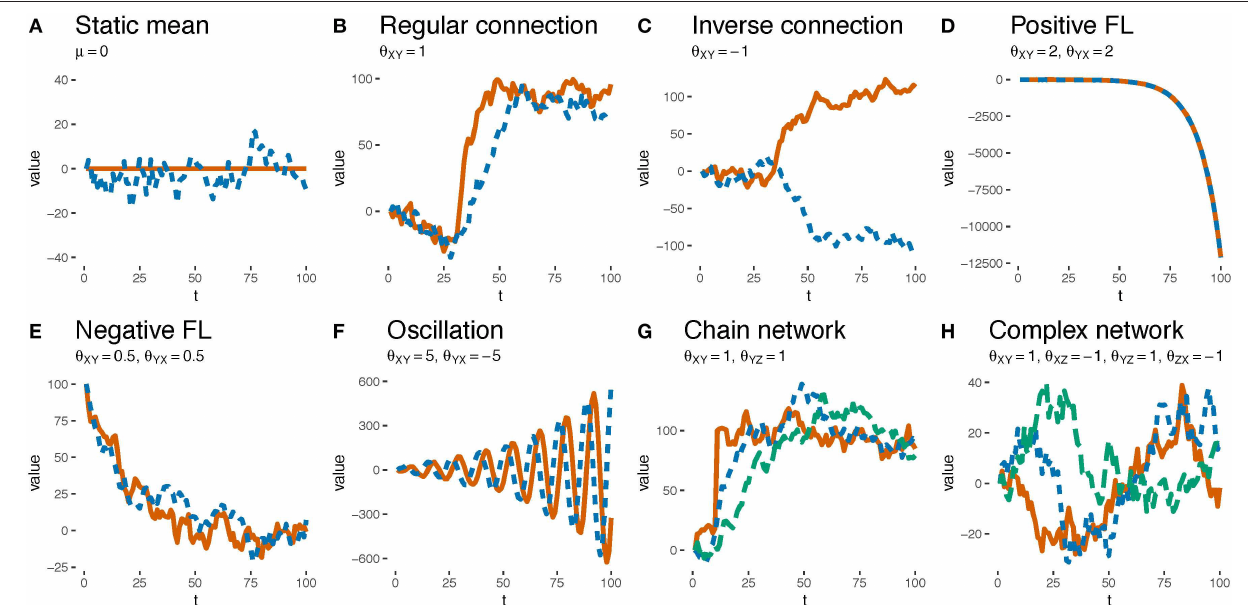
FIGURE 3 | Examples of the dynamical phenomena resultant from varying θ weights. Solid red, dotted blue, and dashed green lines depict the values of variables X , Y , and Z , respectively. (A) A system with a single variable Y whose distribution mean is stationary at 0 (i.e., µ = 0). (B) A system with variables X and Y and a θ weight from X and Y of 1 (i.e., θ XY = 1). µ X = 0 for first 30 timepoints and then µ X = 100 for next 70. The value of Y tracks the value of X . (C) The same as (B) except that X and Y are negatively related ( θ XY = − 1). The value of Y tracks but has the opposite sign of X . (D) A system in which X and Y are reciprocally related via θ weights that are > 1 (i.e., θ XY = θ YX = 2). Because the values of X and Y grow so large they are indistinguishable in the plot. (E) The same as (D) except that X and Y , which have an initial value of 100, are reciprocally related via θ weights that are < 1 ( θ XY = θ YX = 0.5). The values of X and Y eventually fluctuate around 0. (F) The same as (D) except that the reciprocal θ s are large and of opposite sign (i.e., θ XY = 5, θ YX = − 5). The values of X and Y oscillate. (G) A system with three variables whose θ weights form a causal chain, θ XY = θ YZ = 1. µ X = 0 for 10 timepoints but then is set to 100 via an intervention. Note that changes in Y precede changes in Z . (H) Timeseries of actual data observed by participant 10 on trial 10, generated by a complex system with three variables and four non-zero θ s. All variables were initialized at 0 and there were no interventions.